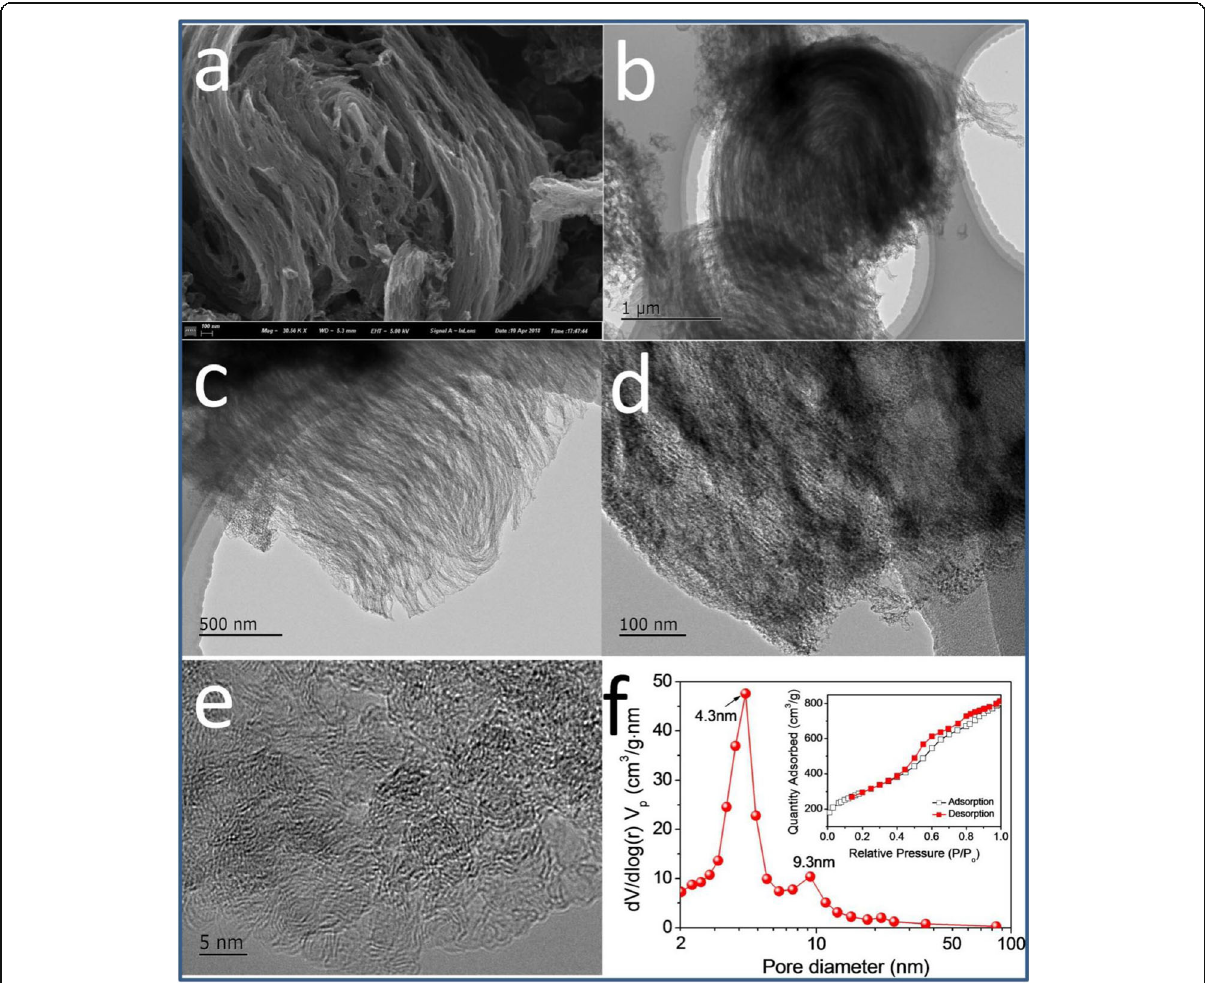
Fig. 6 SEM ( a ) and high-resolution TEM images ( b – e ) of m -Fe/N/C-900; f the pore-size distribution of m -Fe/N/C-900; the inset is nitrogen adsorption-desorption